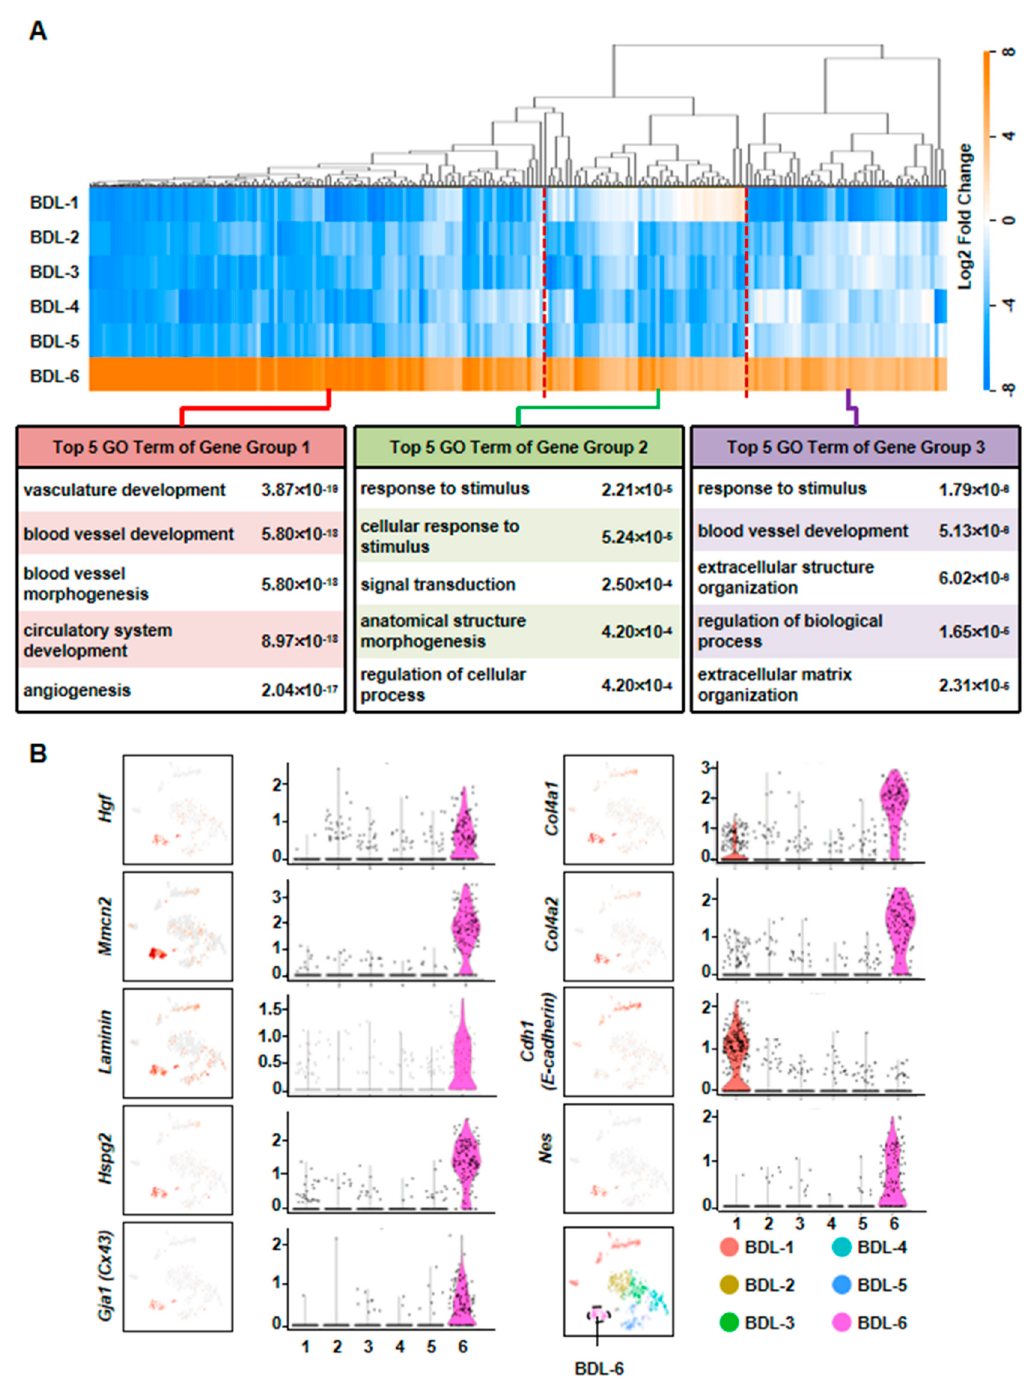
Figure 4. Elucidation of hepatocyte clusters participating in tissue repair. ( A ) Hierarchical cluster and GO analysis of Top 200 high expressed genes of BDL-6 in BDL sample. ( B ) Enrichment pattern of genes in the BDL-6.